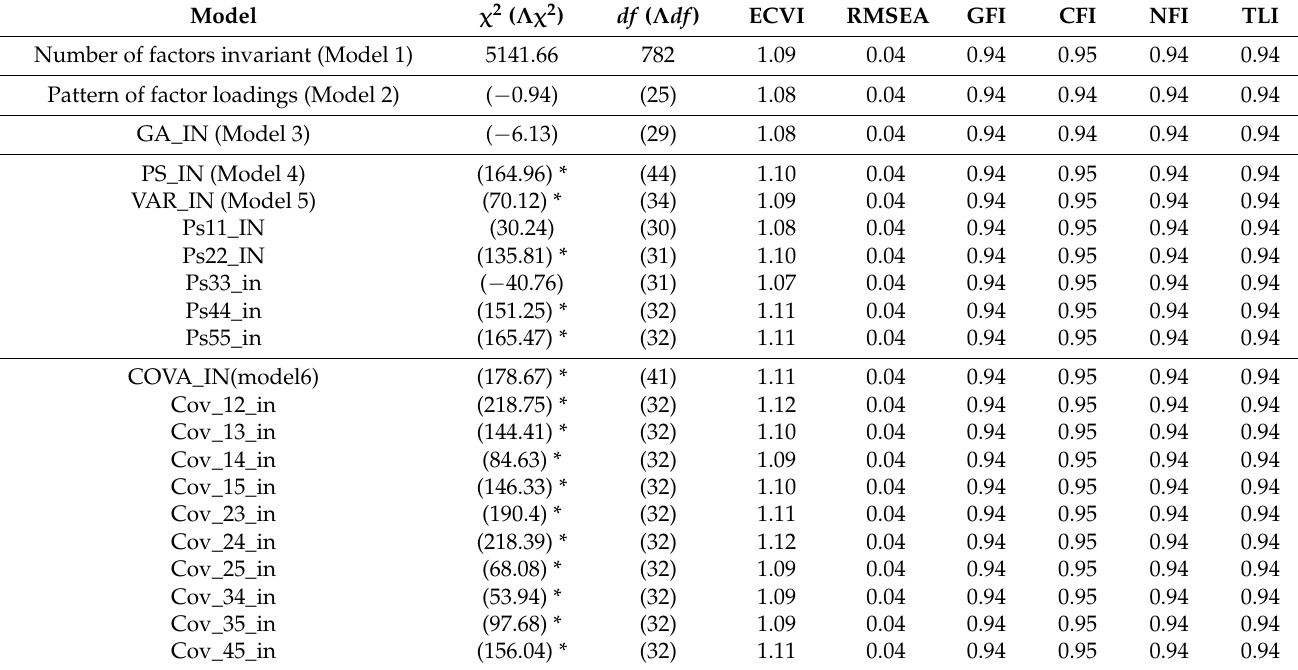
Table 5. Invariance by